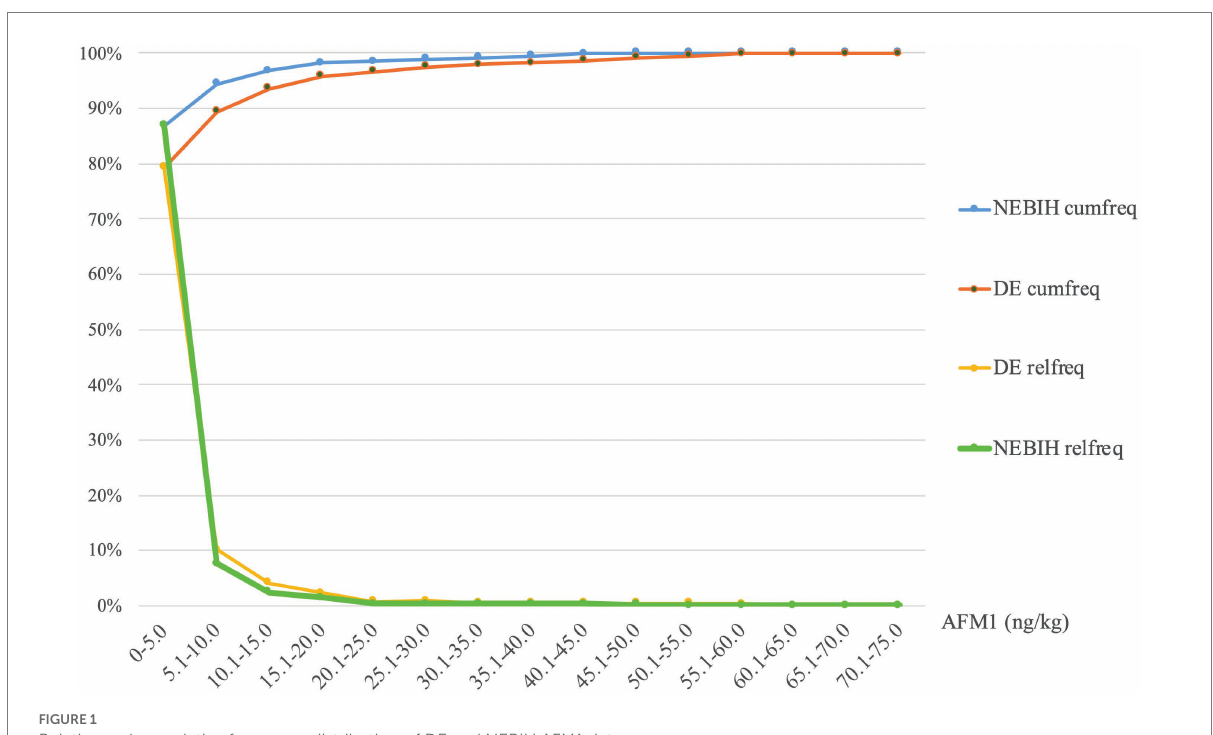
FIGURE 1 Relative and cumulative frequency distribution of DE and NEBIH AFM1